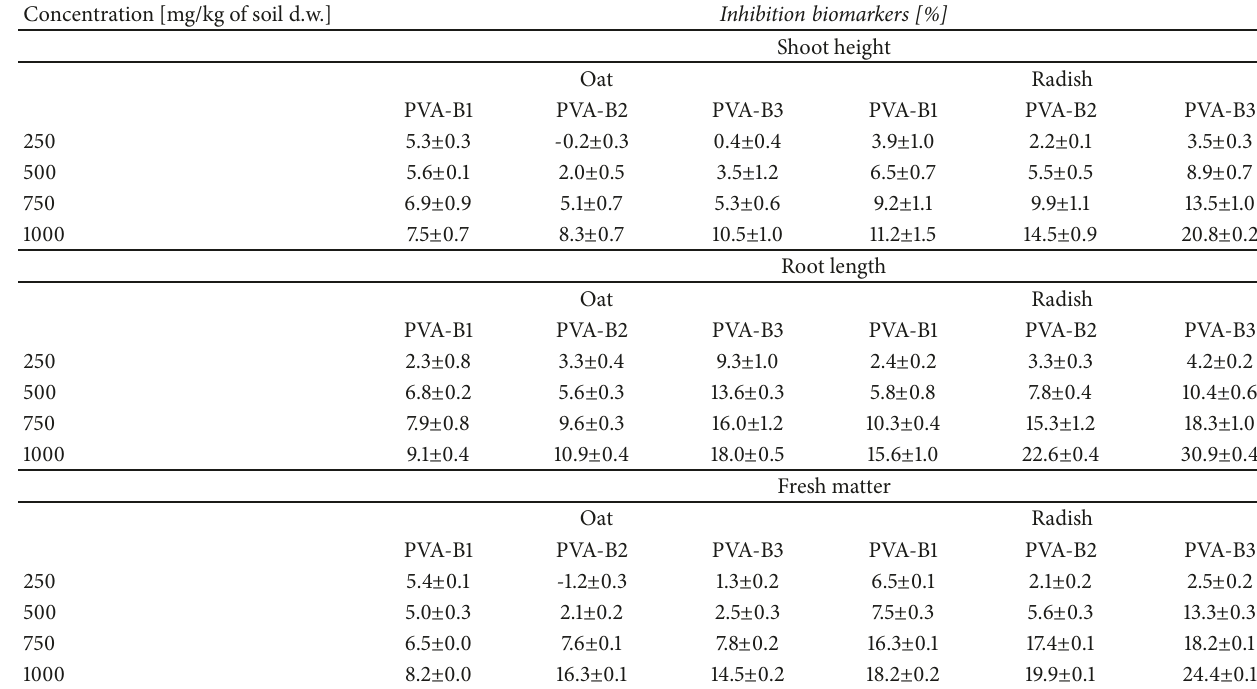
Table 4: Effect of PVA-B1, PVA-B2, and PVA-B3 hydrogels on the shoot height, root length, and fresh matter of oat and radish seedlings (mean ± SD). Concentration [mg/kg of soil